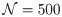
Colony morphology with negative phototaxis (UV light).The colony farthest to the East is the closest to a UV light source, and experiences the greatest light intensity, and hence the largest pphoto. As shown in the bottom panel, pphoto decreases linearly towards the West. At each time point, an individual cell can either detect the UV light and move away from it, or can move in a random direction. Each colony contains N=500 cells, and the model was simulated for 4 × 104 time steps.